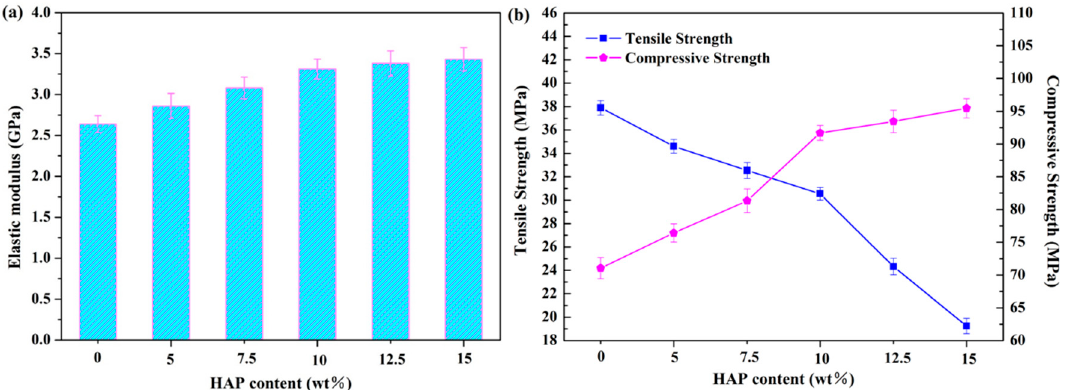
Figure 5. Elastic modulus, compressive strength and tensile strength of the scaffolds with different HAP contents.